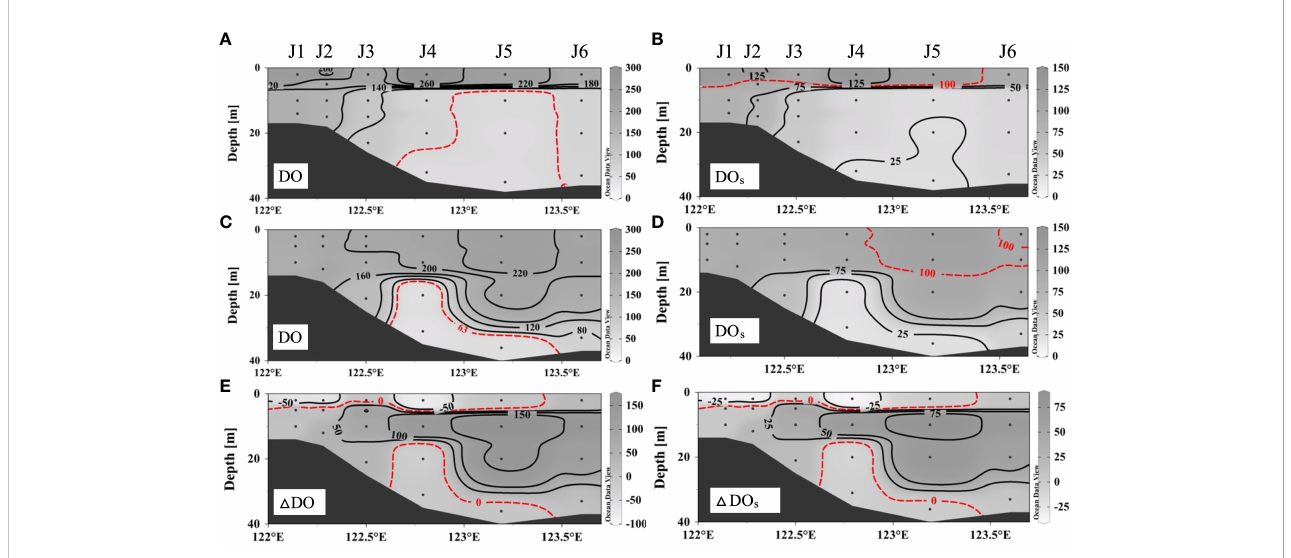
FIGURE 3 Dissolved oxygen distributions and saturation of dissolved oxygen along section J before wind (A, B) and after wind (C, D) and the differences between repeated observations (E, F)